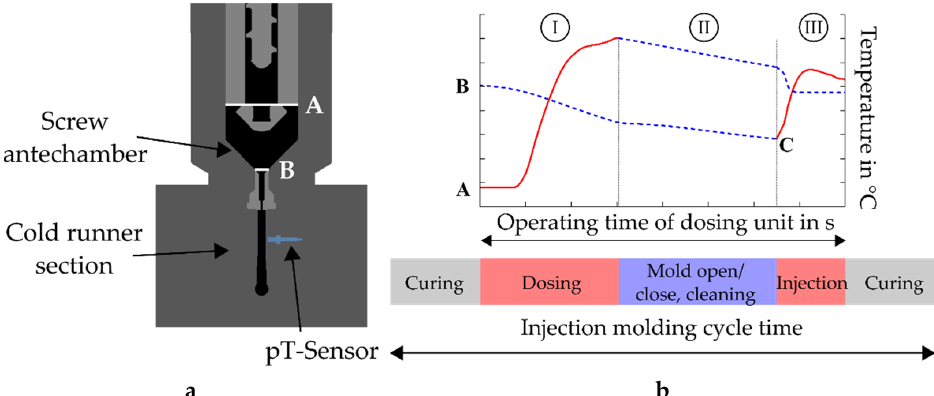
Figure 3. ( a ) Simplified simulation setup considering the measured temperature profile at inlet A to calculate the profile during injection at point B; ( b ) simulated temperature profiles during the operating time of the dosing unit, where C indicates the set temperature for simulations without the dosing unit. The three sections describe the phases (I) dosing, (II) retention time, and (III) injection of the entire injection molding process.